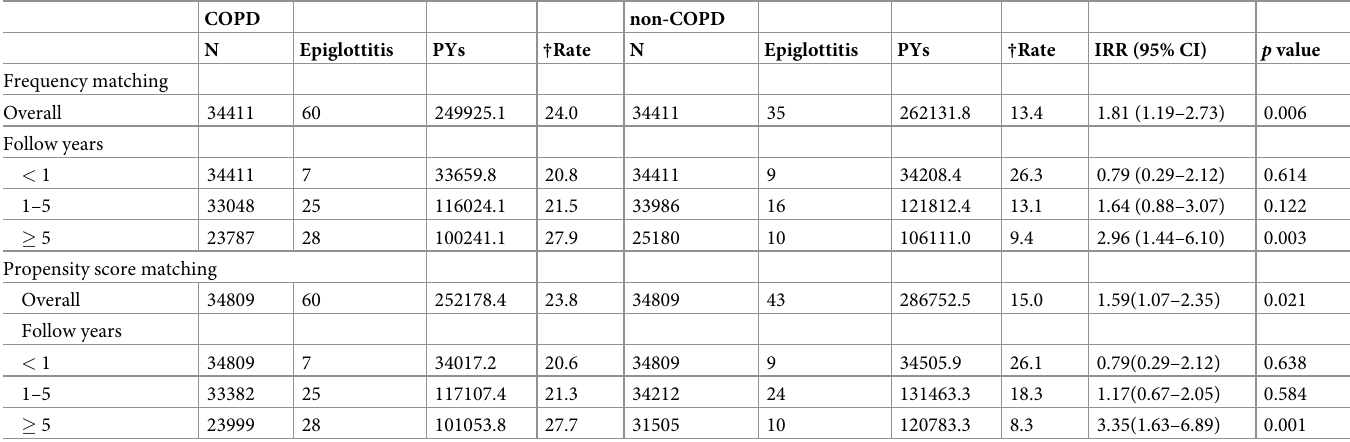
Table 2. Overall epiglottitis incidence in COPD and non-COPD cohorts.